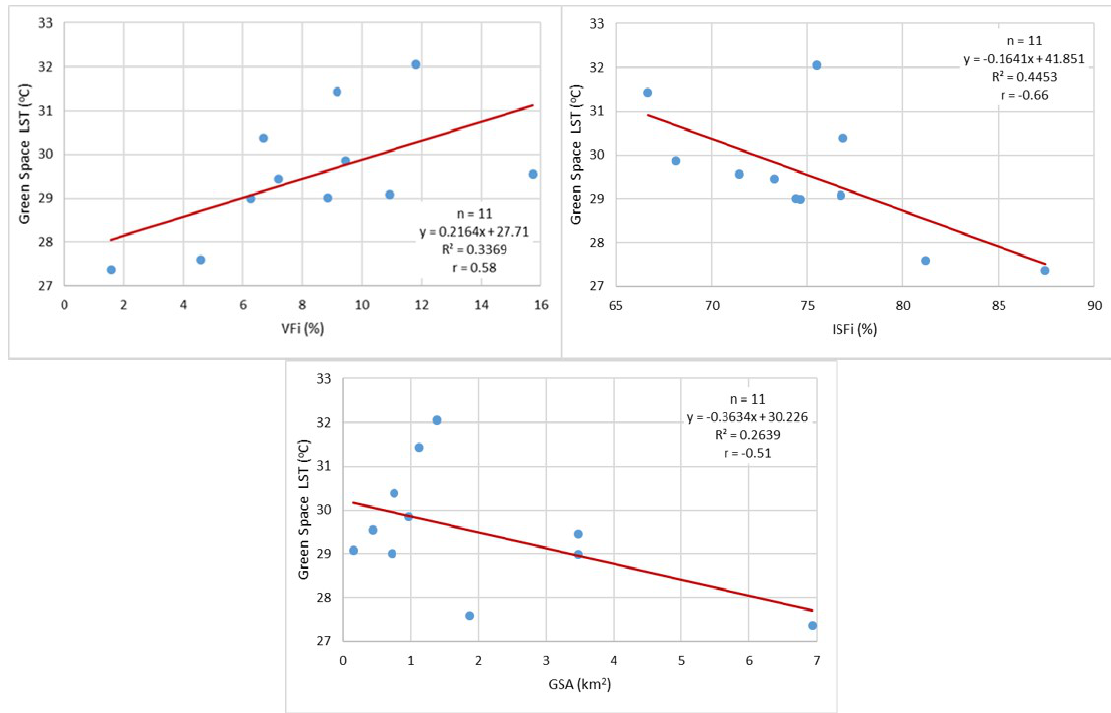
Figure 9. Correlation between LST and impact factors of Islamabad.